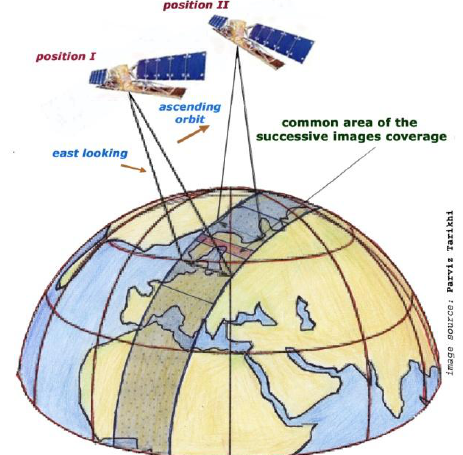
Figure 3: Coverage area of two successive SLC images